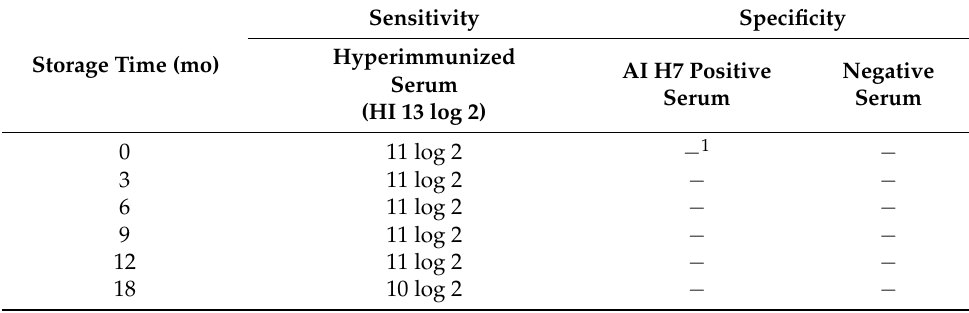
Table 4. Sensitivity and specificity of the bLFA strip at different storage times.